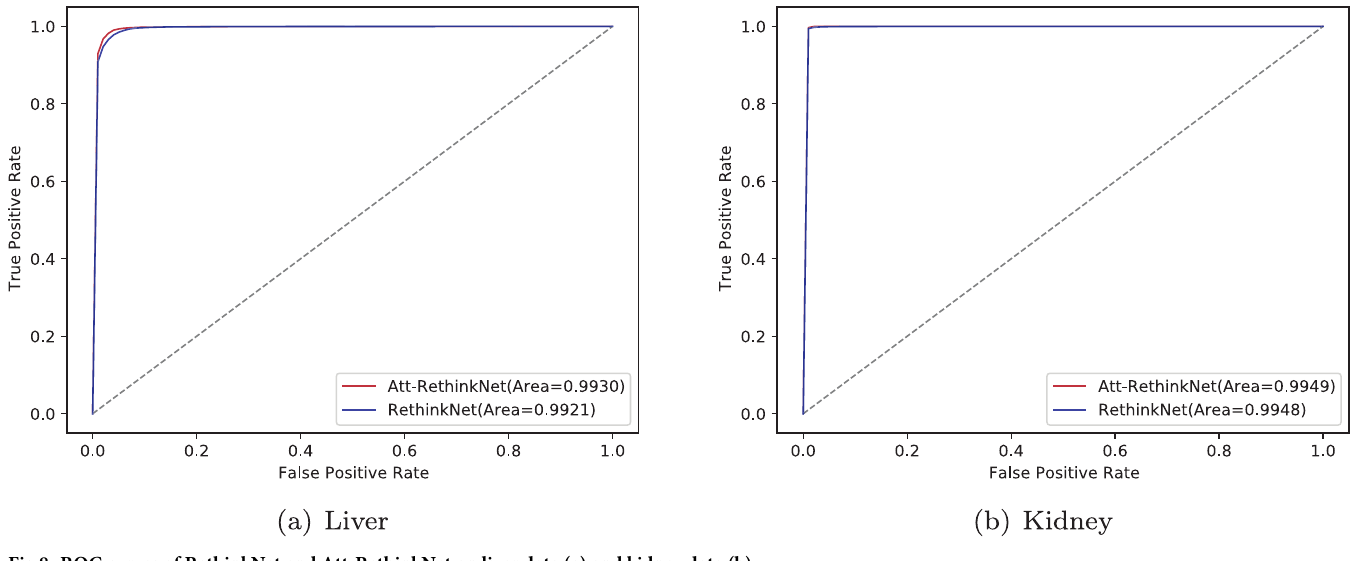
Fig 8. ROC curves of RethinkNet and Att-RethinkNet on liver data (a) and kidney data (b).